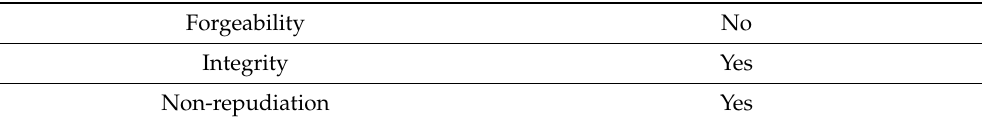
Table 1. Security Analysis of Proposed Digital Signature Scheme.